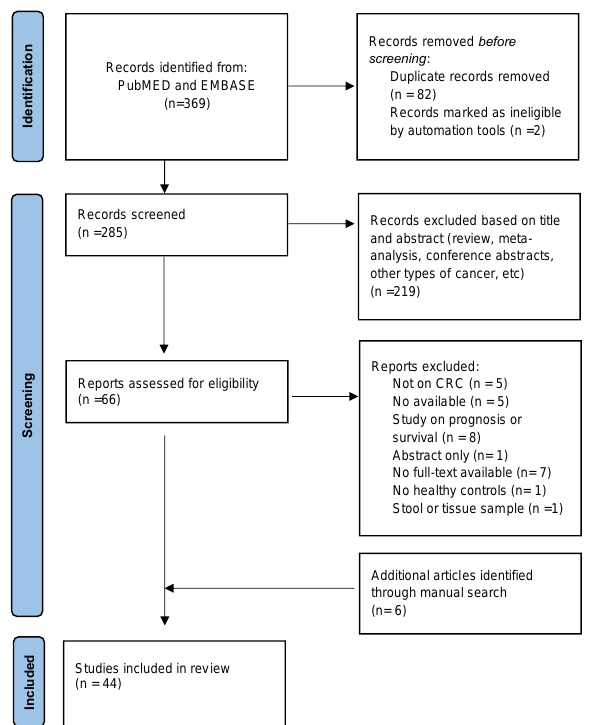
Figure 1. Flowchart of the systematic literature search according to PRISMA guidelines.